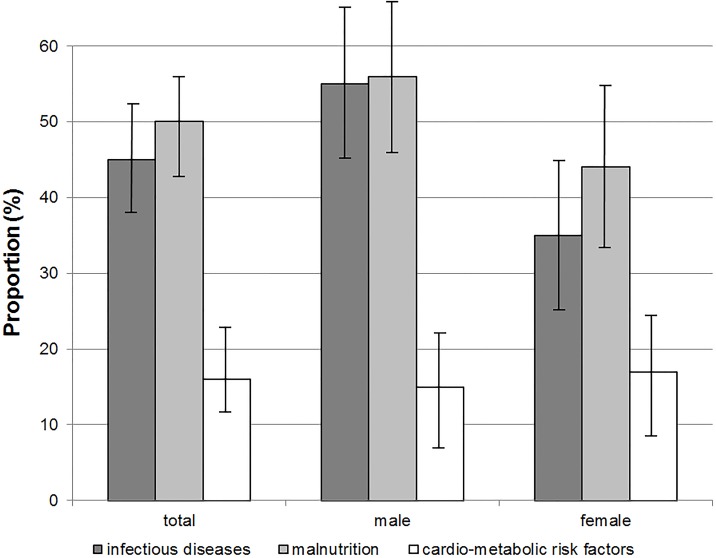
Proportions of infectious diseases, malnutrition and cardio-metabolic risk factors in 188 adolescents in rural Ghana.Error bars indicate 95% confidence intervals. dark grey = infectious diseases, comprise malarial infection plus diagnoses of and symptoms compatible with another infectious disease; light grey = malnutrition, comprises underweight, stunting, iron deficiency and vitamin A deficiency; white = cardio-metabolic risk factors, comprise overweight, obesity, impaired fasting glucose and hypertension.